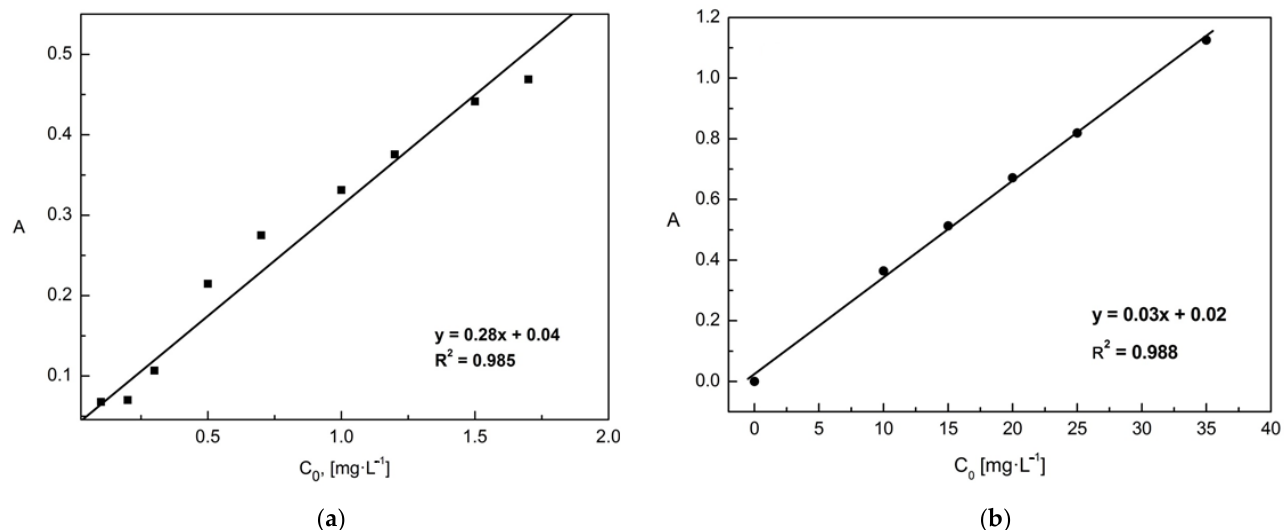
Figure 1. Determined appropriate absorption coefficient ( ε ) necessary for the determination concen- tration of: ( a ) phosphates ions and ( b ) chromates ions.